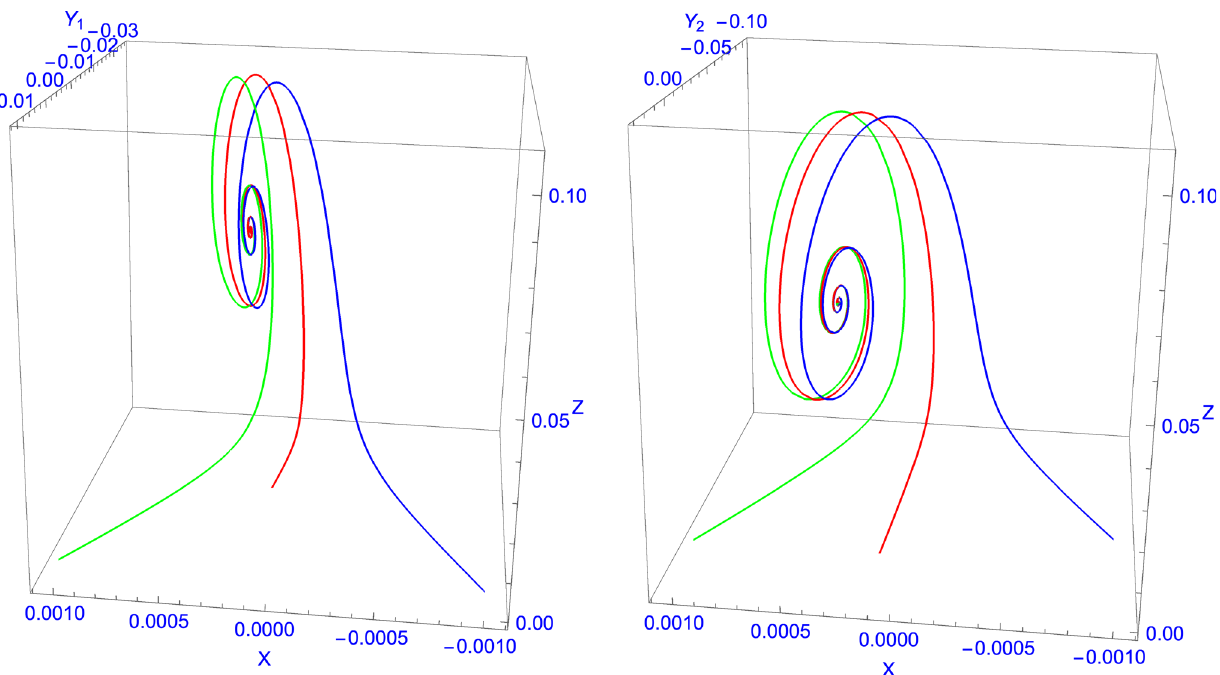
Fig. 1 Attractor behavior of the anisotropic fixed point with the field parameters chosen as ω = + 1, λ 1 = 0 . 1, λ 2 = 0 . 2, ρ 1 = 50, and ρ 2 = 100. These two plots clearly display that trajectories with different colors corresponding to different initial conditions all converge to the anisotropic fixed